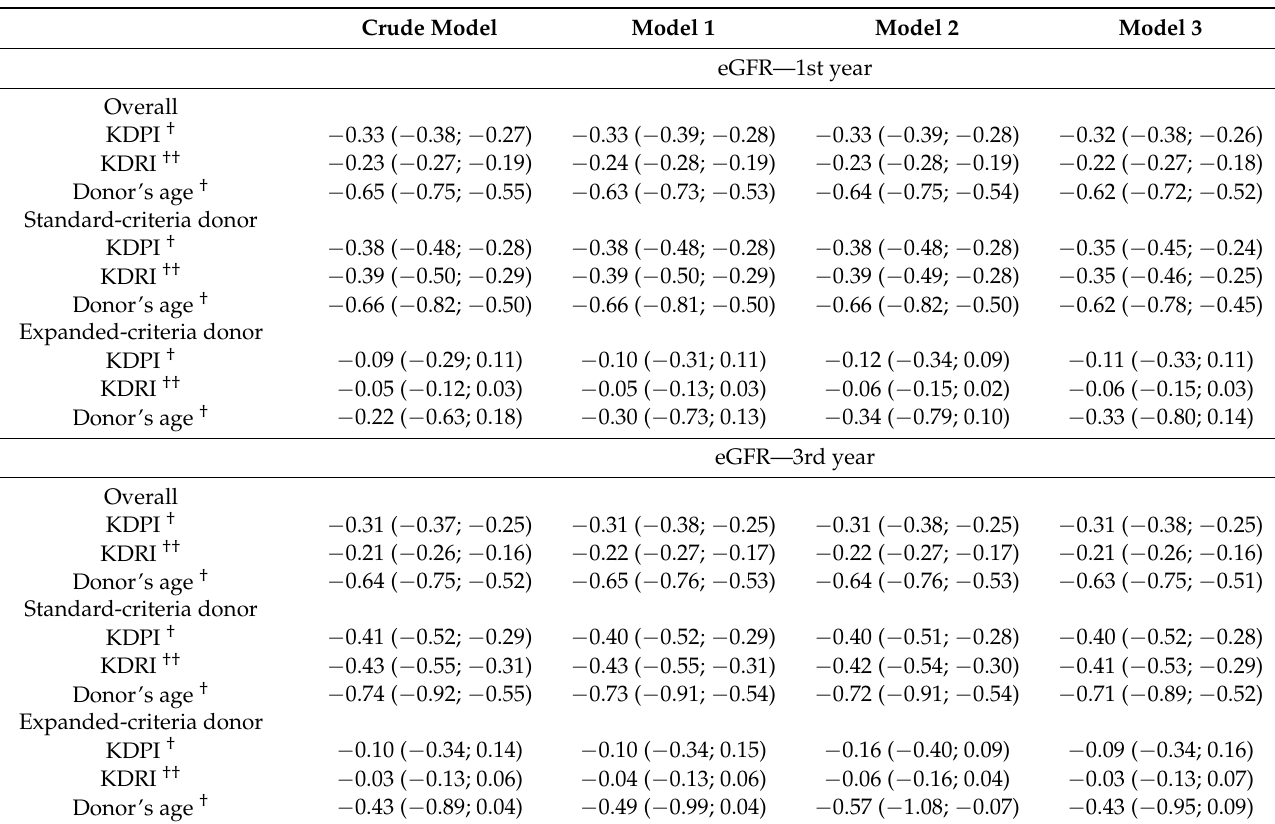
Table 2. Linear regression analysis outcomes evaluating the effects of KDPI, KDRI, and donor’s age on renal function at the first, third, and fifth post-transplant